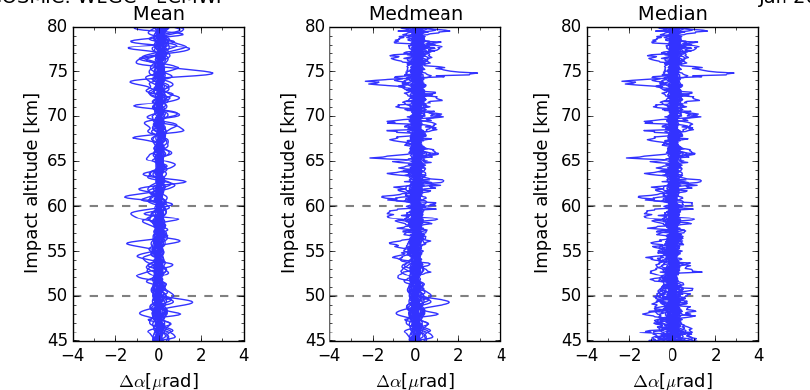
Figure 2. L1b WEGC: bending angle difference of mean, medmean, and median relative to ECMWF analyses for January 2011.